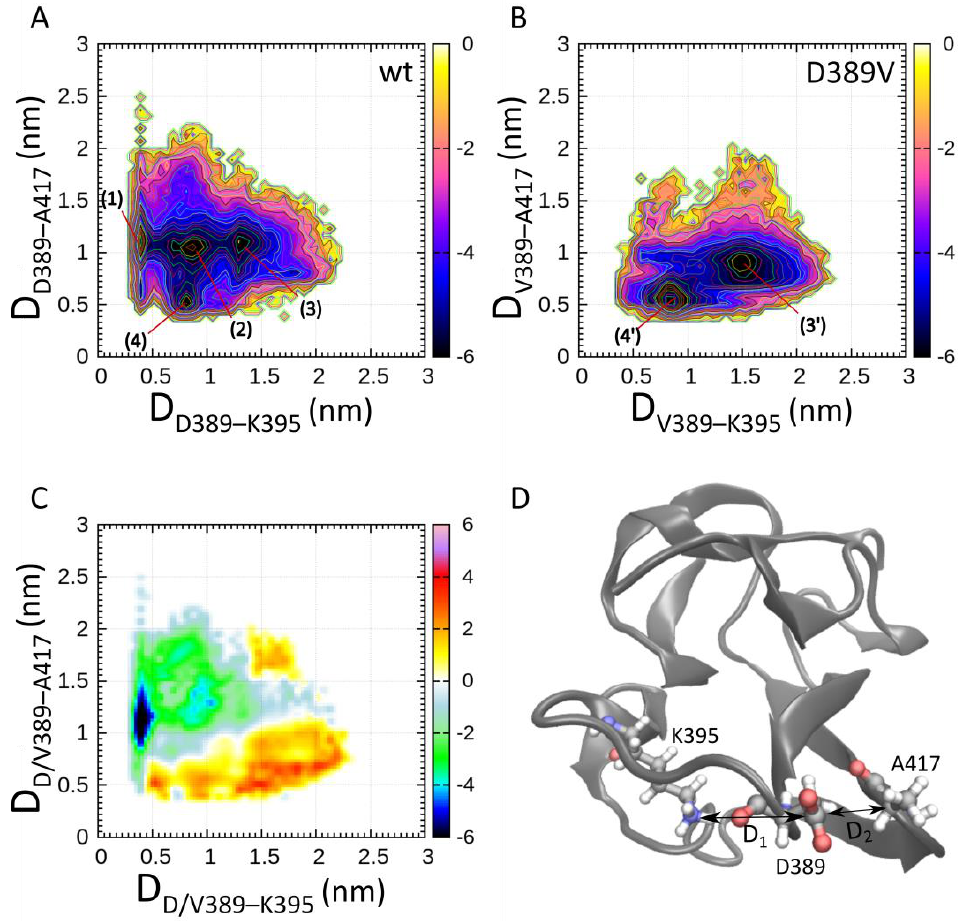
Figure 2. Free energy landscapes of MyBPC C2 wt ( A ) and D389V ( B ) domains generated using 100 ns of CORE-MD II simulations. The effect of the D389V mutation on the conformational space in the vicinity of the mutation is explored. We define the interatomic distances between D389V Cγ/V389 Cβ–K395 Nζ and D389V Cγ/V389 Cβ–A417 Cα as principal coordinates of the FEL. The scale of the color bar is given in units of k B T and represents the free energy 𝛥𝐹 (see Equation (5), Section 4.3). (1) to (4) indicate conformational states of C2 wt, and (3′) and (4′) indicate those of C2 D389V. ( C ) Free energy differences 𝛥𝛥𝐹 between C2 wt and C2 D389V (see Equation (6), Section 4.3). Negative values indicate an abundance of wt, and positive values indicate an abundance of D389V states. ( D ) Sample conformer extracted from State (4) in ( A ). C2 wt is depicted with the interacting residues D389, K395, and A417. D 1 represents the x-axis and D 2 represents the y-axis of the distances plotted in figures ( A ) to ( C ) for all conformations adapted over the course of the simulation. A sample conformer of State (4) is displayed in Figure 2D. The C2 D389V free energy landscape (Figure 2B) and the difference map between C2 wt and D389V (Figure 2C)